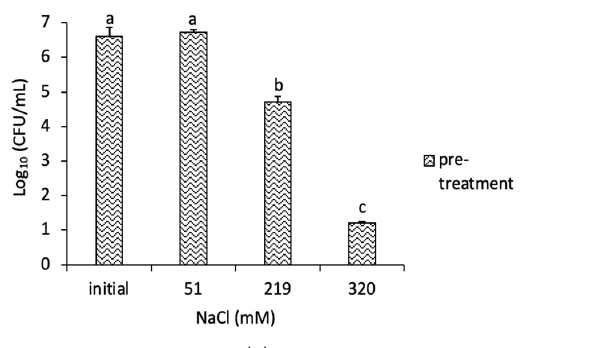
of planktonic cells following 24 h exposure to constant NaCl concentrations (51, 219 and 320 mM) and and 320 mM) and incubation with deionized water (control) or 85 mg/mL GO. Mean values with